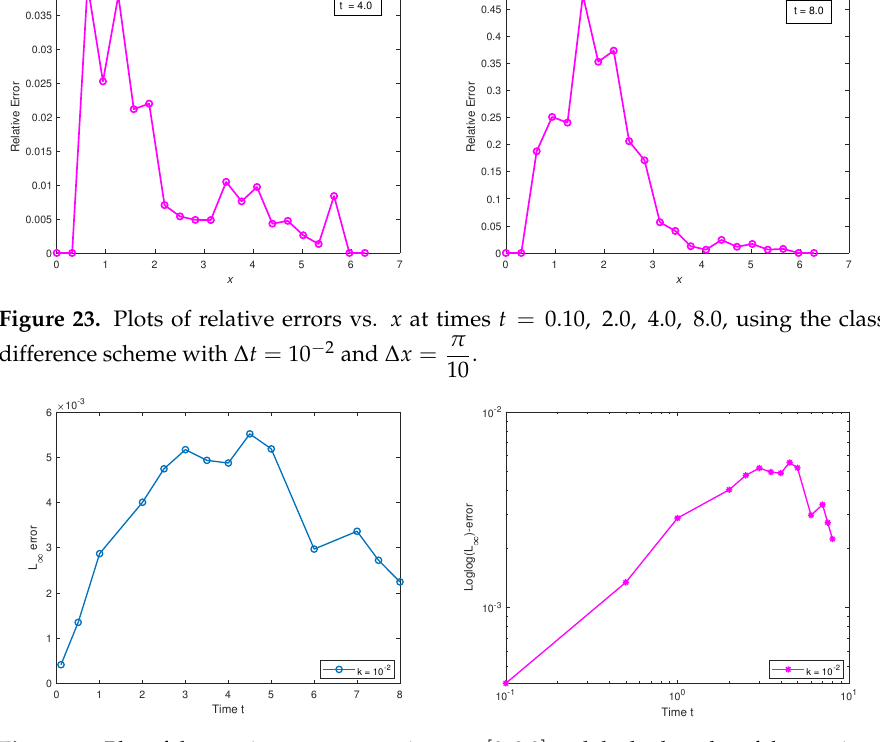
Figure 24. Plot of the maximum error vs. time t ∈ [ 0,8.0 ] and the loglog plot of the maximum error vs. time t with ∆ x = π and ∆ t = 1.0 × 10 − 2 , using the standard finite difference scheme, 10